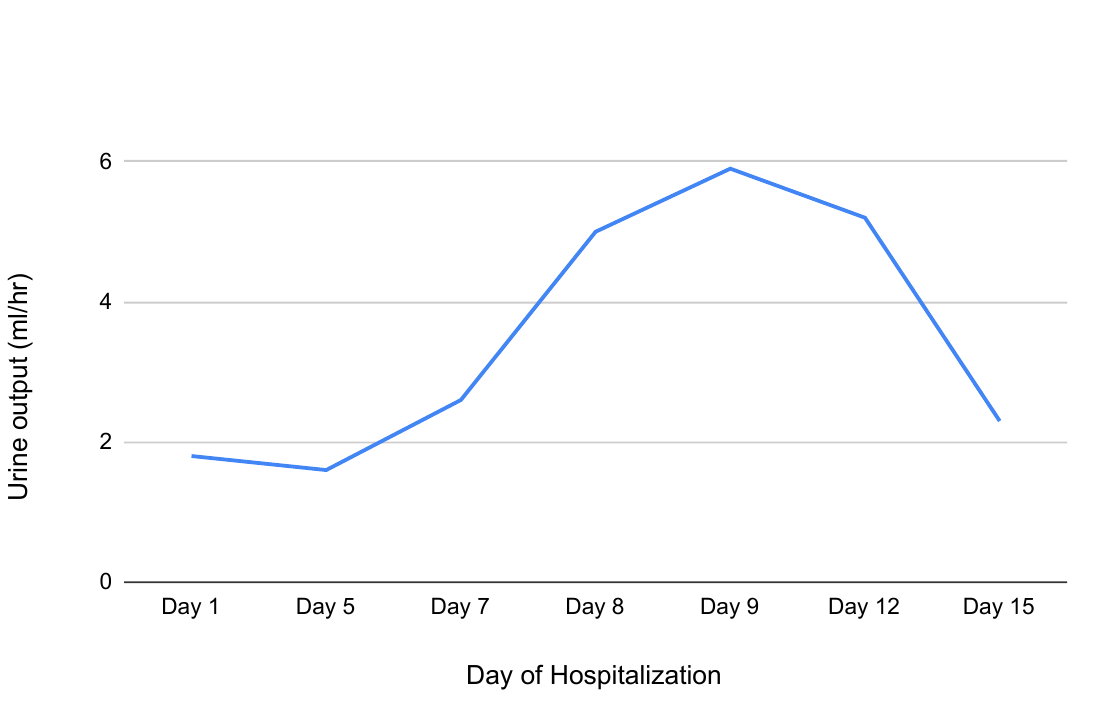
Fig. 1. Urine pH during hospital course